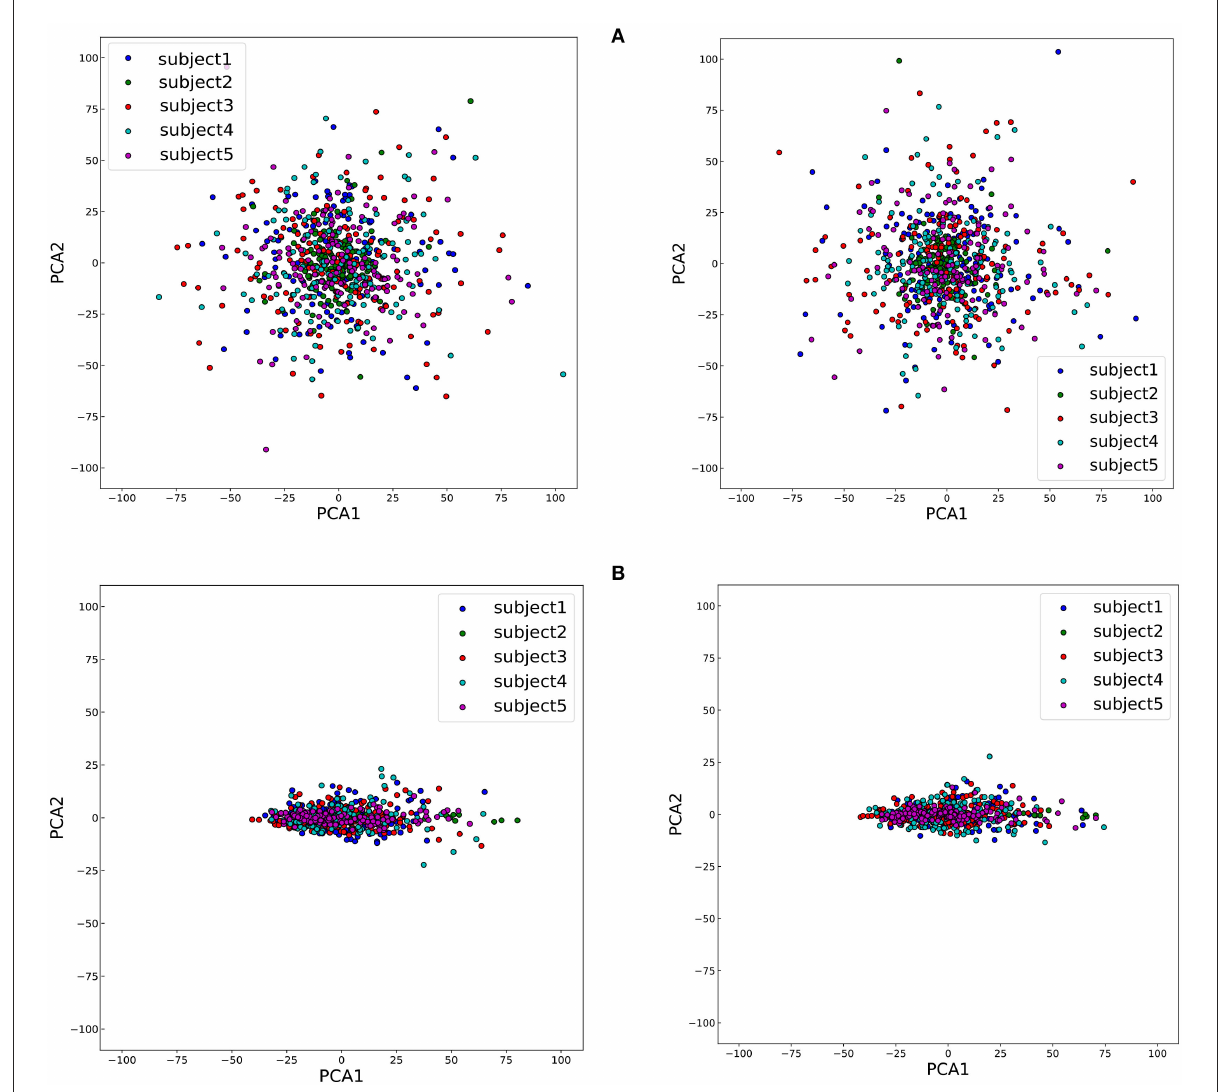
FIGURE6 The disparity among five subjects of two classes, right hand and feet, which are on the left and right of the figure, respectively. (A) The visualization of sample distributions of raw EEG data. (B) The visualization of sample distributions of the SPD